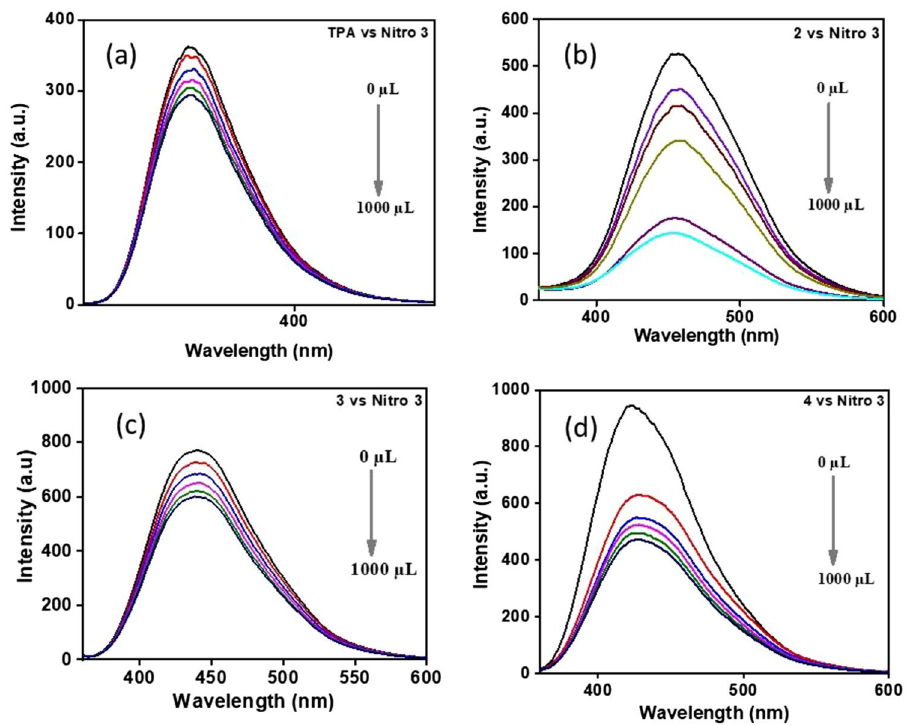
Figure 4. Fluorescence spectra of compounds 1 – 4 in the presence of 4-Nitrotoluene (Nitro 3). The concentration of 4-Nitrotoluene in DMSO is in the order of 0 M, 9.09 × 10 −5 M, 16.6 × 10 –5 M, 23.0 × 10 −5 M,